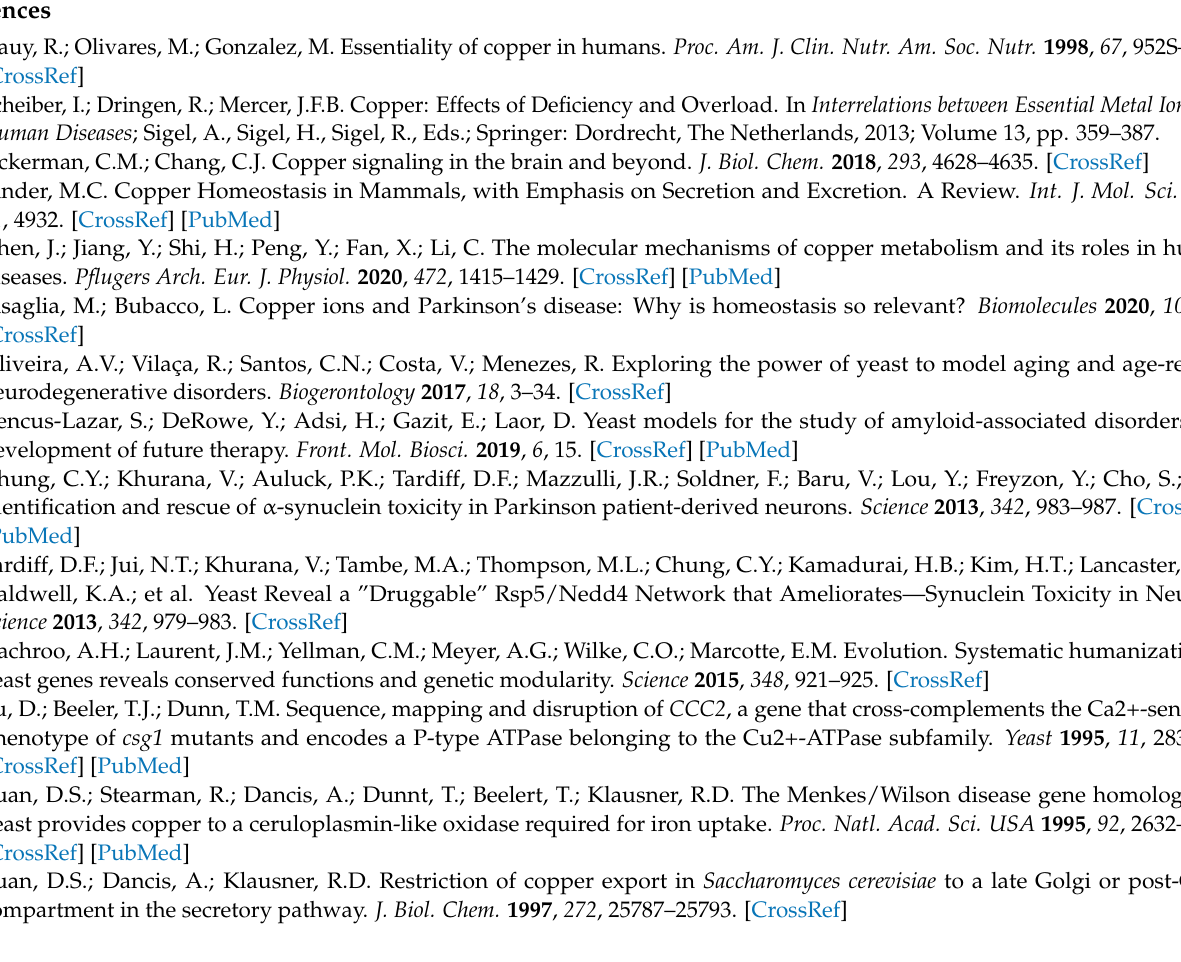
Figure A2. CTR1 overexpression suppresses vps13 ∆ hypersensitivity to cadmium and very weakly suppresses hypersensitivity to canavanine. Growth of wild type and vps13 ∆ strains bearing plasmid with CTR1 gene or empty vector was compared by a drop test on plates with YPD, YPD + CdCl 2 and SC –arg + canavanine